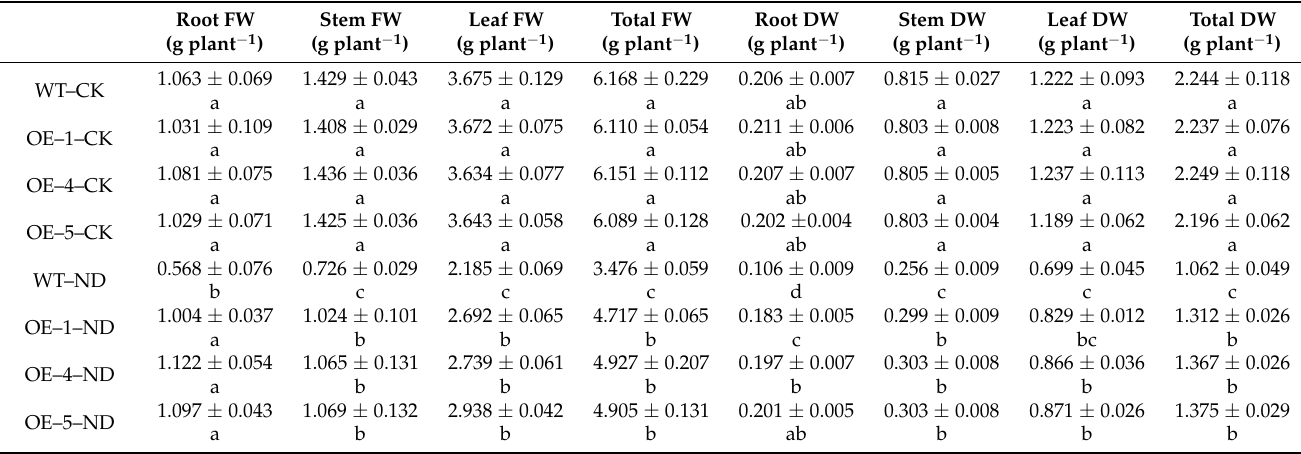
Figure 2. Overexpression of MdATG10 alleviated the growth limitation of apple plants under nitrogen-deficiency stress. ( a ) Phenotypes of WT and transgenic apple plants under control hydroponic conditions and after 28 d of treatment with 0.15 mM nitrogen-deficiency stress. Bars: 5 cm. ( b ) Plant height, ( c ) root length, ( d ) relative growth rate, and ( e ) root–shoot ratio of WT and transgenic plants with or without treatment. Data are shown as the means of six replicates with SEs. Different letters indicate significant differences between treatments, according to one-way ANOVA followed by Tukey’s multiple range test ( p < 0.05). Table 1. Tissue fresh weights (FW, g) and dry weights (DW, g) measured from WT and MdATG10 -OE plants after 28 d of nitrogen-deficiency treatment.